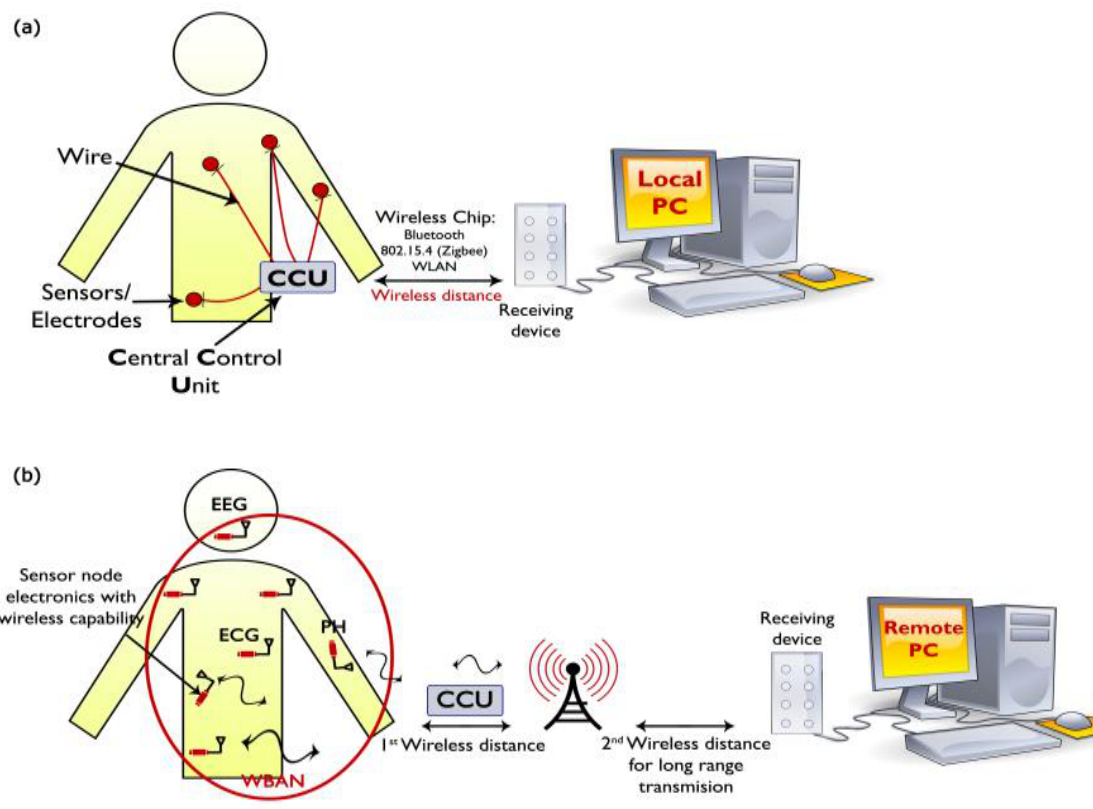
Figure 2. A typical WSN system for detecting and transmitting signals from a human body: (a) current application of healthcare sensor network and (b) future application of healthcare sensor network targeted by wireless body area